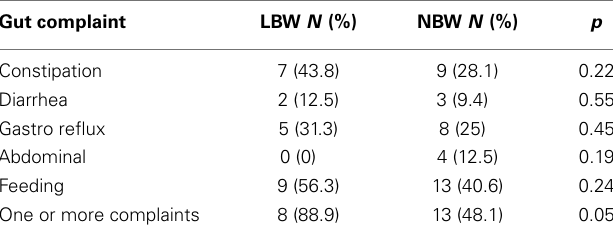
Table 6 | Study 2: chi-square analyses using Fisher’s exact test for both groups of children for the five gastrointestinal